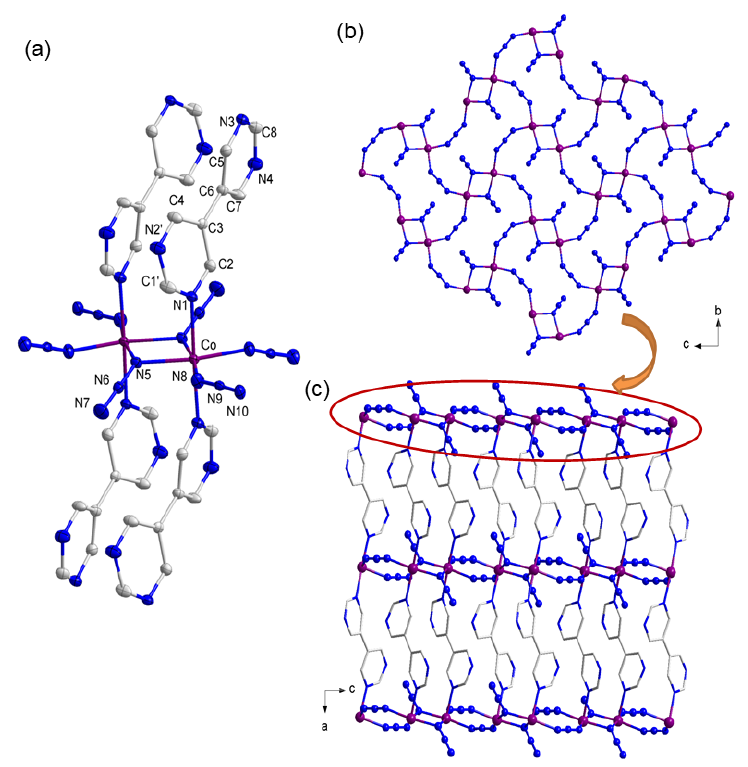
Figure 1. ( a ) The local coordination environment of Compound 1 ; ( b ) the 2D Co 2 -EE-N 3 layer; ( c ) the pillared-layer 3D structure of 1 . The H atoms of bpym ligand have been omitted for clarity.